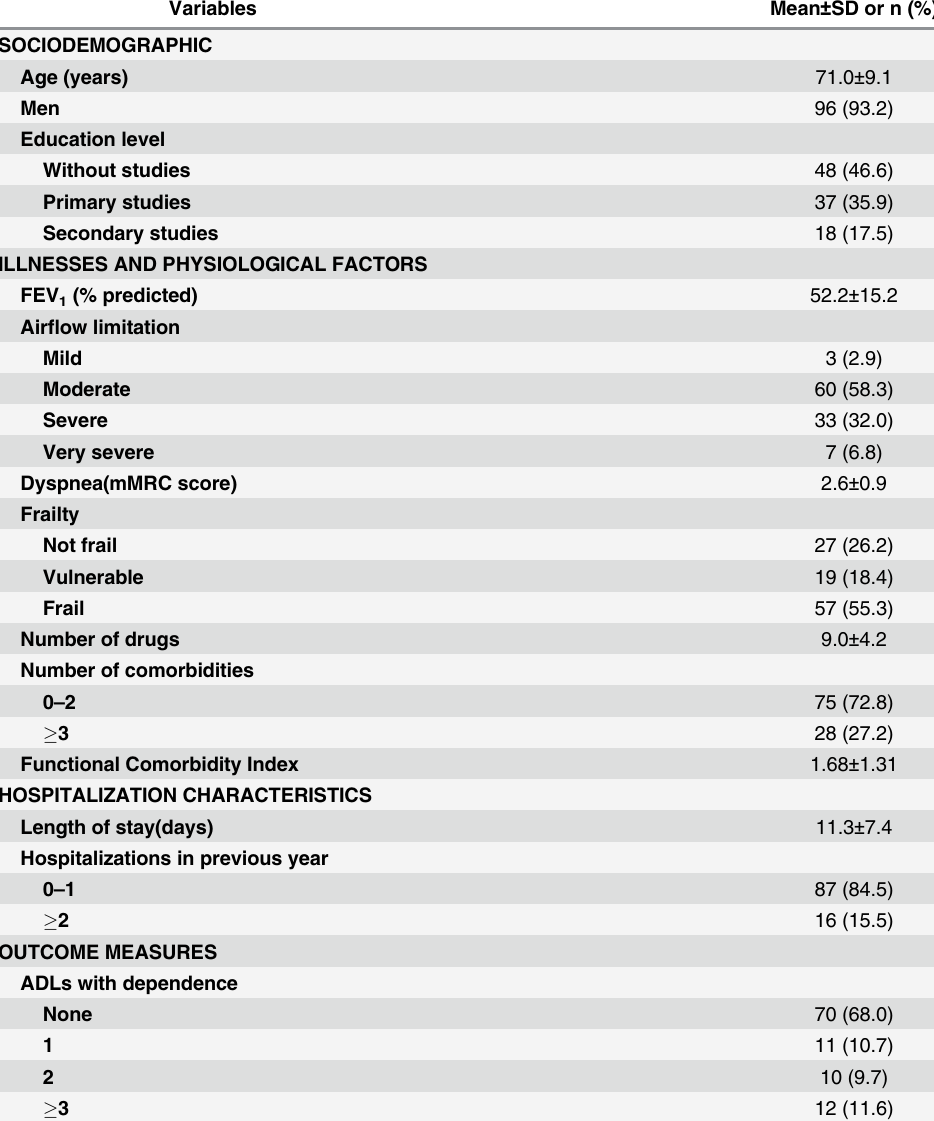
Table 1. Characteristics of the Study Population at Baseline. (N =